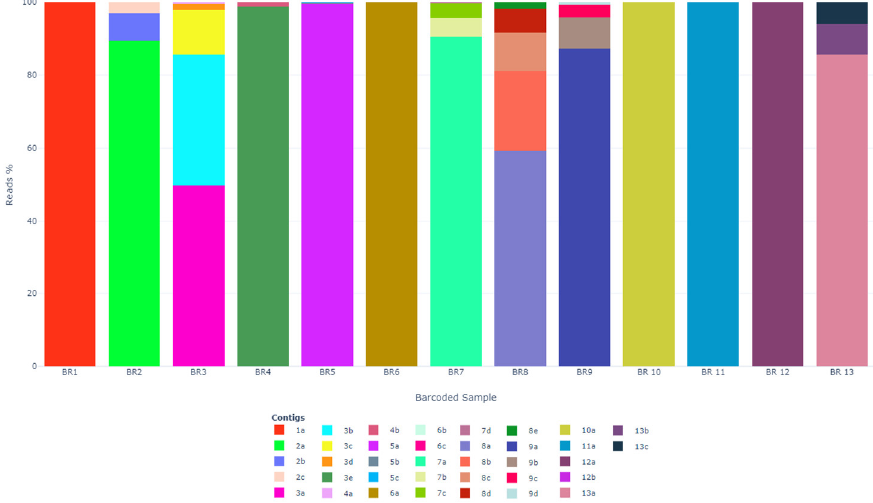
Figure 2. Bar chart showing reads per sequence type’s composition in each barcode (BR). BR7, BR8 and BR9 each contained 3 or 4 pooled samples (11 samples in total).